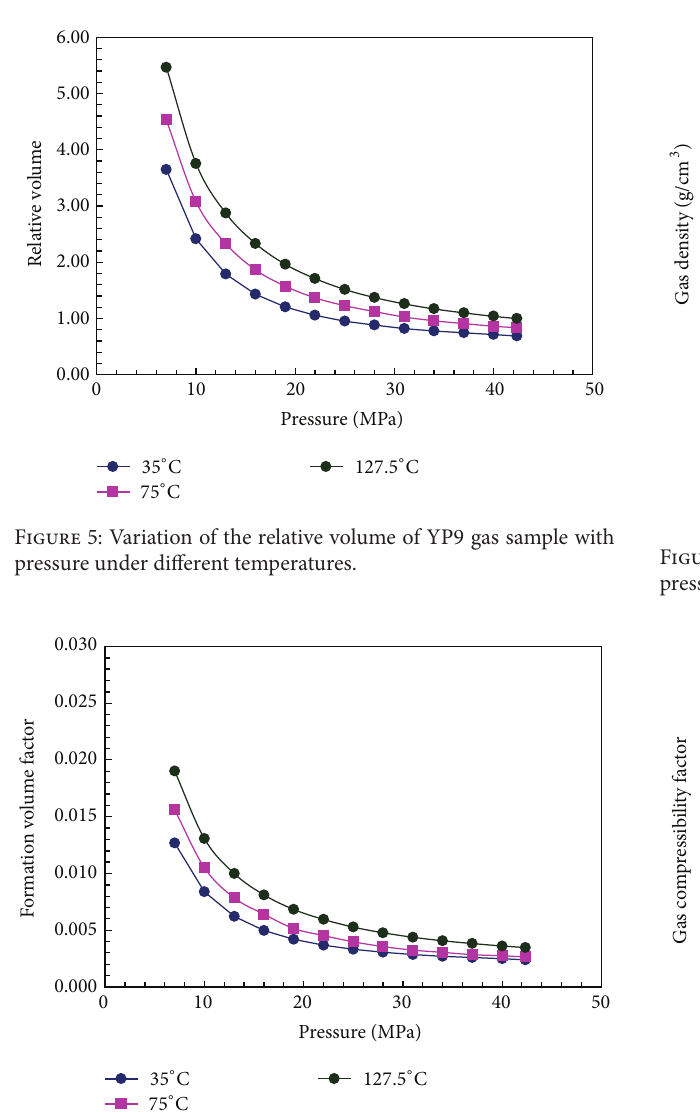
Figure 6: Variation of the formation volume factor of YP9 gas sample with pressure under different temperatures.